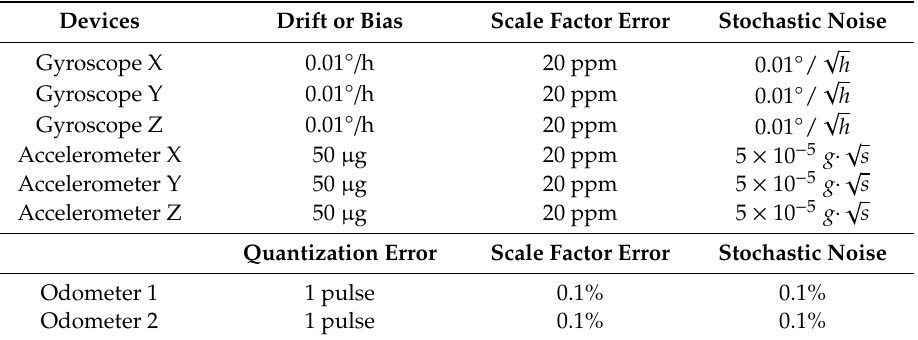
Table 1. Parameters of the system devices.